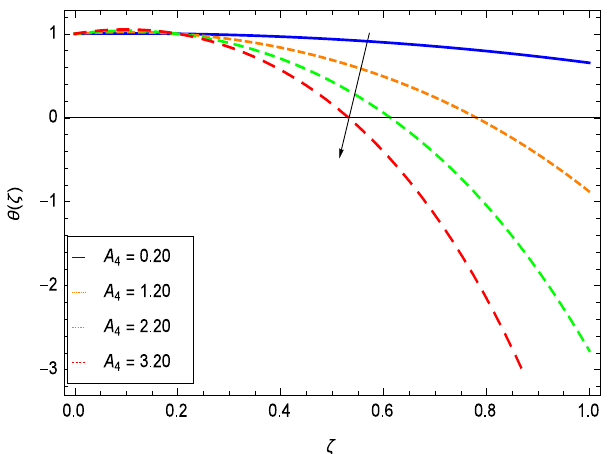
Figure 16. Conduction layer at h = − 1.80, β = 0.10, φ = 0.40, n = 1.50, We = 0.50, S = 0.50, Nr = 1.00, M = 2.00, Pr = 10.00, A 3 = 0.20, A = π with the enhancement in A 4 . 4